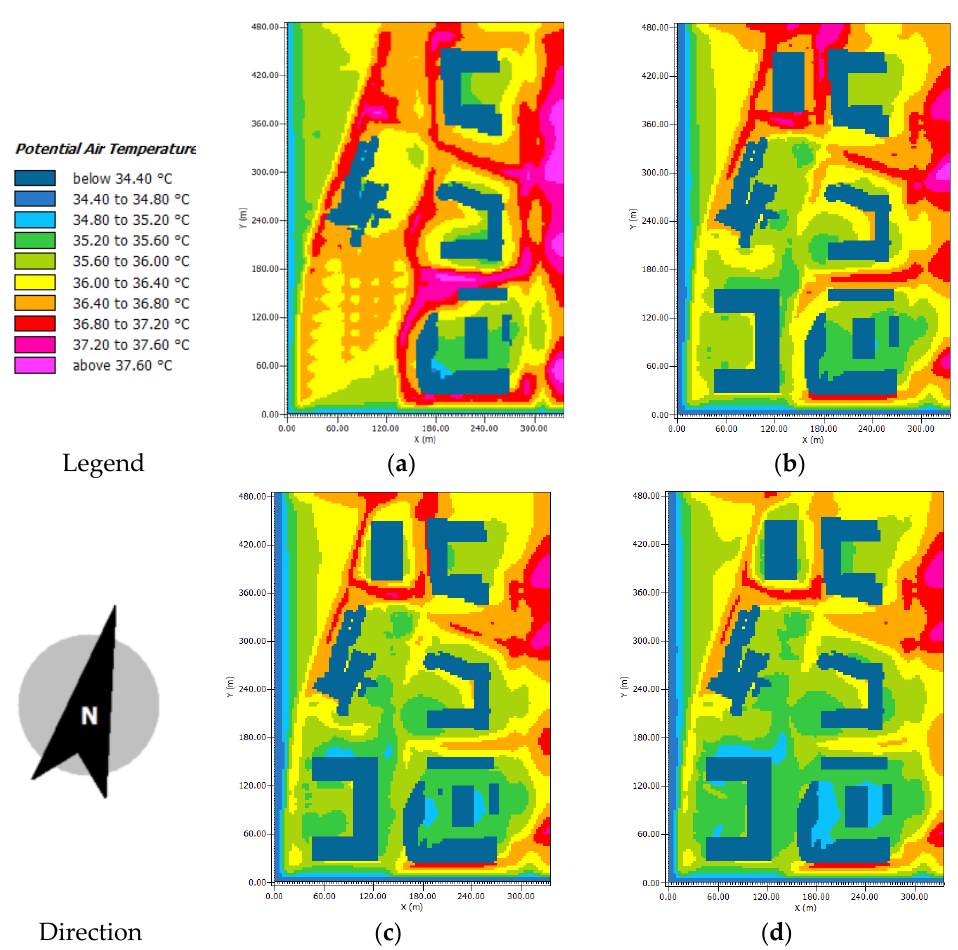
Figure 13. Comparison of simulated T a obtained at the height of 1.5 m at 15:00 for different H/W. ( a ) Base case (A0); ( b ) H/W = 0.8 (A4); ( c ) H/W = 1 (A5); ( d ) H/W = 1.2 (A6).